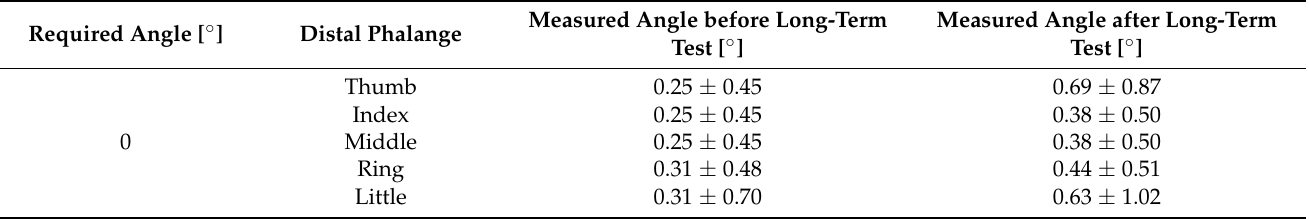
Table 2. Verification of distal phalange measured at an angle of 0 ◦ before and after the long-term test. Required Angle [ ◦ ]